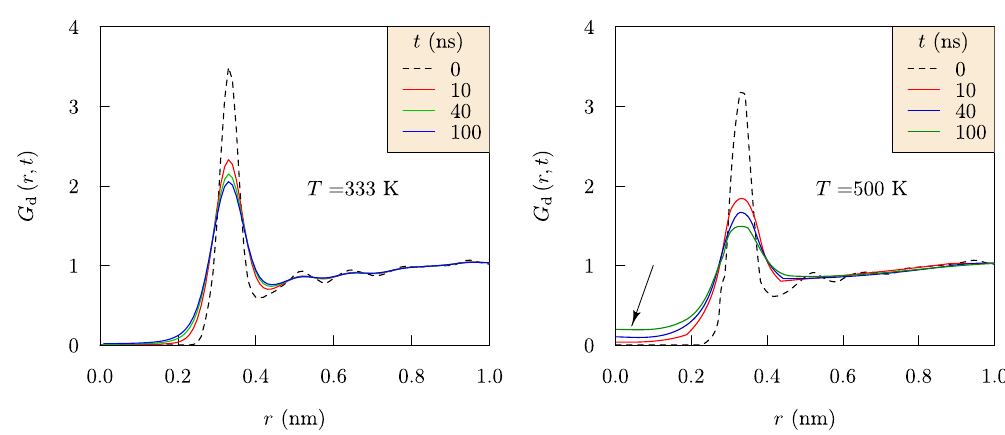
Figure 7. The Li-Li radial distribution function in EDC at t = 0 (dashed) and the corresponding distinct part, G d ( r , t ), of the van Hove function within the Vineyard approximation. The non-zero population in the core region surrounding r ≈ 0 (right panel) describes correlation of Li + jumps, i.e ., refilling a hole left by a Li + ion with a neighboring Li + ion. (Left panel is redrawn with permission from ECS Transactions 77, 1155–1162 (2017)) 13